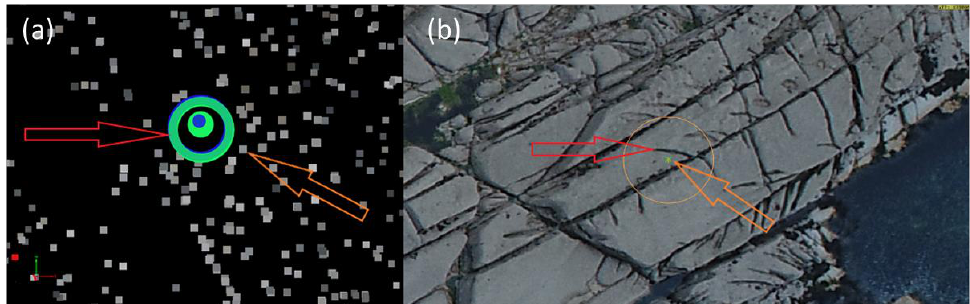
Figure 2. ( a ) A key point close to the GCP is chosen for manually marking the GCP on images. The orange arrow represents the selected key point, and the red arrow represents the measurement point of the GCP, which is the endpoint of a bedrock fracture ( b ).